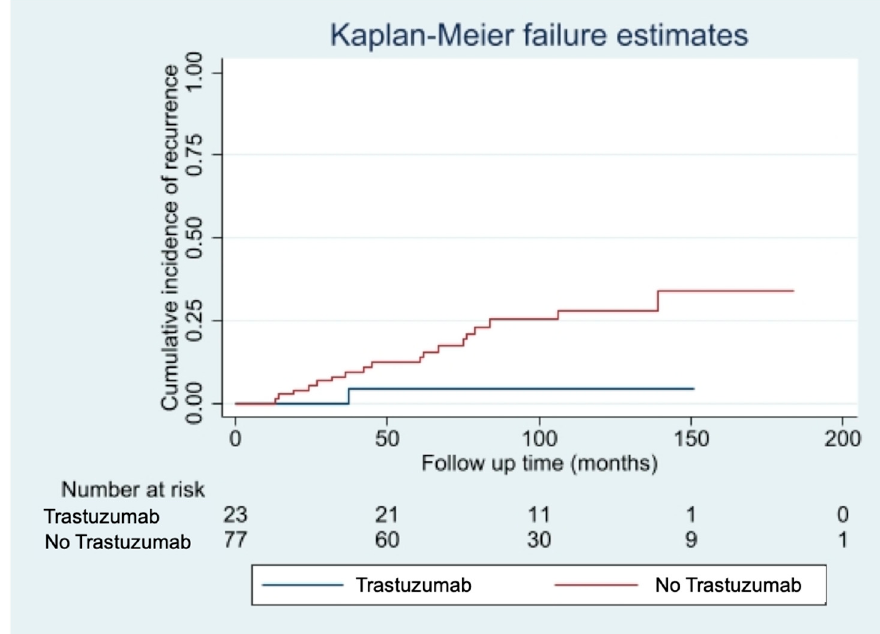
Figure 1. Cumulative incidence of disease recurrence according to treatment with Trastuzumab.